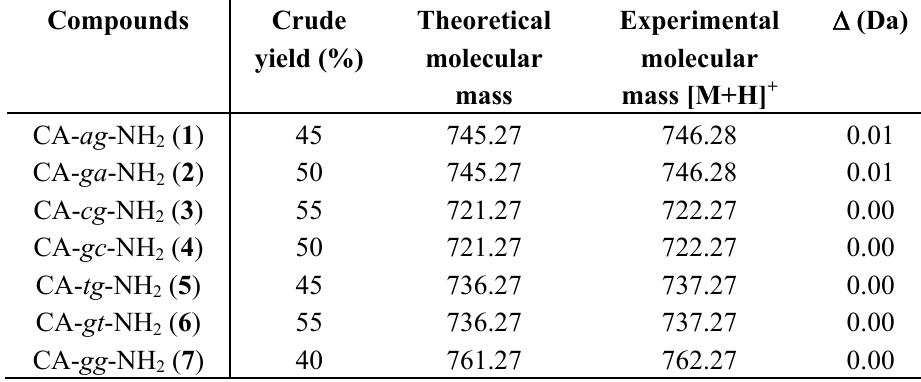
Table 1. Crude yield and MALDI-TOF MS analysis of CA-PNA